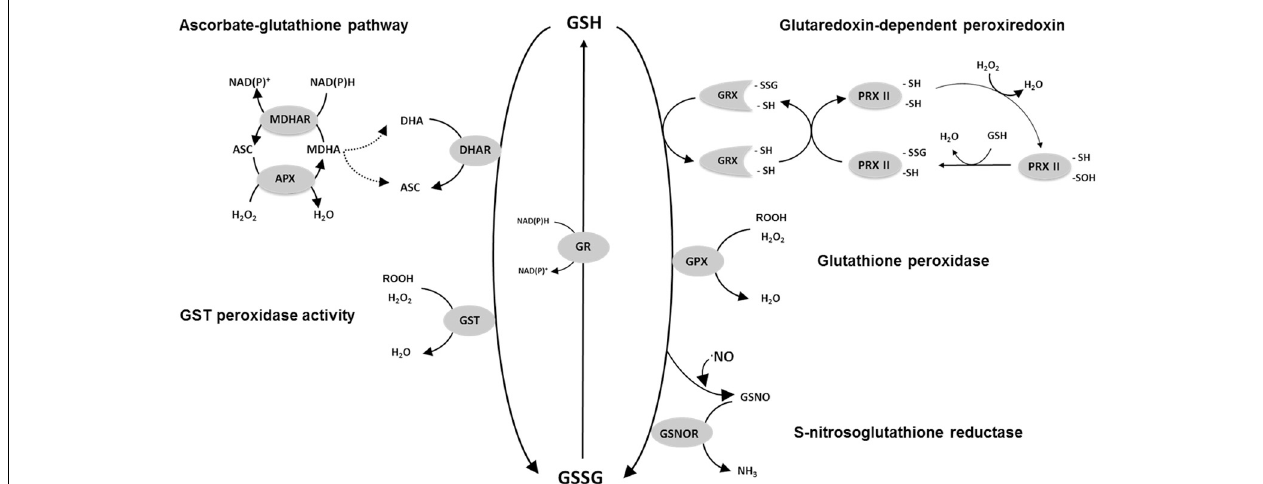
FIGURE 1 | Scheme of some of the possible reactions involved in GSH oxidation in plants. Not all possible reactions or reaction mechanisms are shown. For reasons of clarity, stoichiometries are not depicted. For PRXII a proposed regeneration mechanism of Prx IIE using the GSH/Grx system is shown according to Gama et al. (2008). Abbreviations: GSH, reduced glutathione; GSSG, glutathione disulphide; GR, glutathione reductase; DHAR, dehydroascorbate